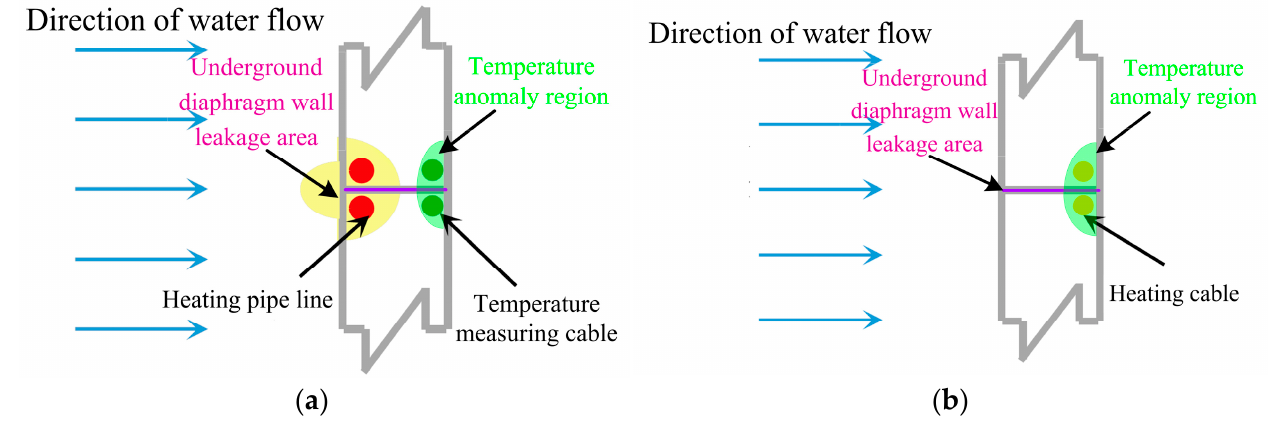
Figure 1. Active and passive temperature field leakage schematic diagram ( a ) Active temperature field leakage; ( b ) Passive temperature field leakage.